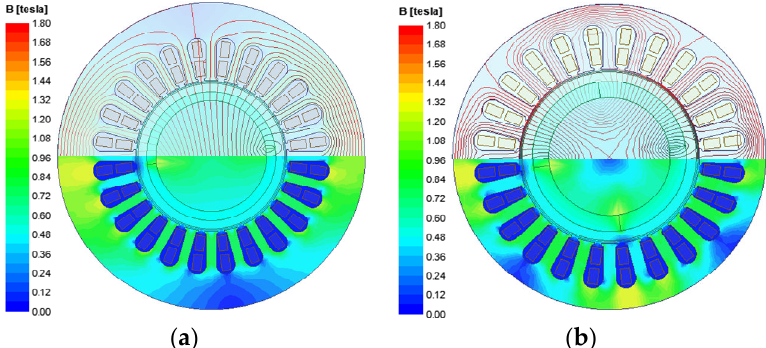
Figure 6. Magnetic flux density and lines distributions of two ‐ pole and four − pole motors at no ‐ load: ( a ) two ‐ pole motor; ( b ) four ‐ pole motor.